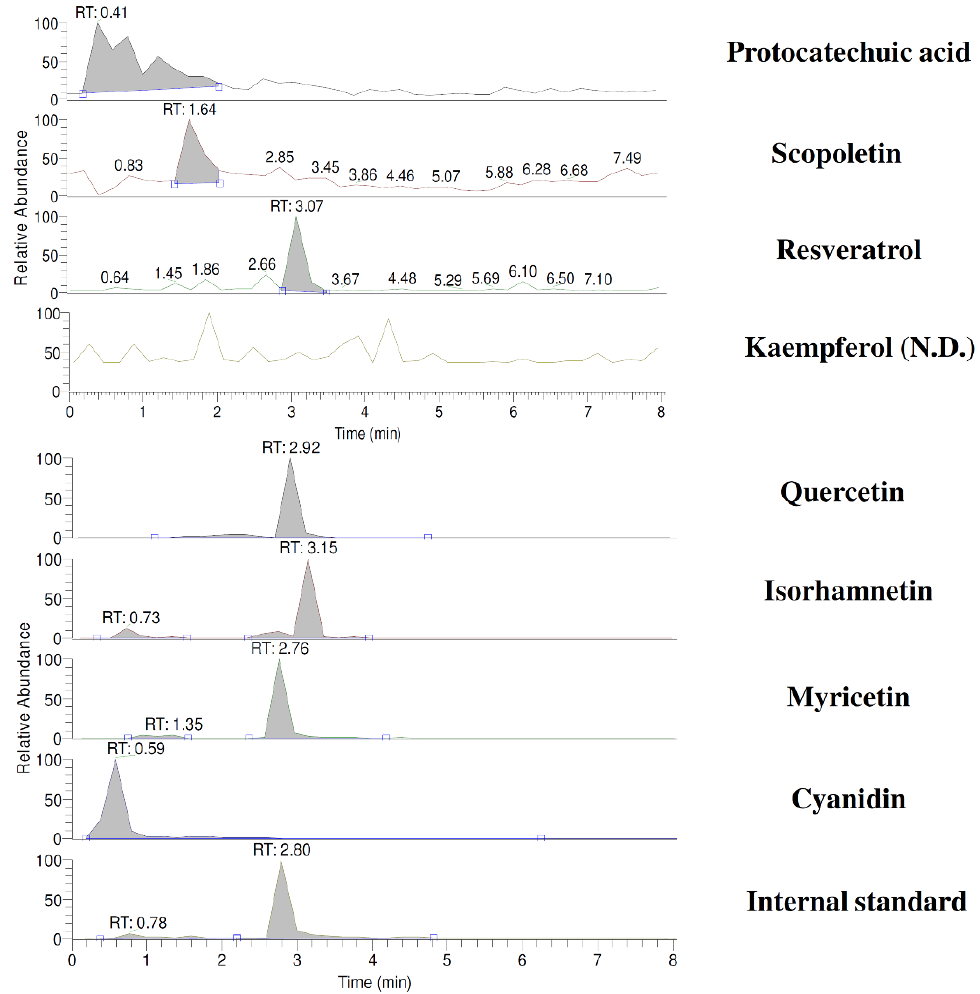
Figure 1. LC/MS/MS chromatograms of cranberry juice. SRM: protocatechuic acid ( m / z 153/108); scopoletin ( m / z 191/176); resveratrol ( m / z 227/185); kaempferol ( m / z 285/151); quercetin ( m / z 301/151); isorhamnetin ( m / z 315/151); myricetin ( m / z 317/151); cyanidin ( m / z 287/213); internal standard, 6,7-DMC ( m / z 207/151). Table 1. Pharmacokinetic parameters of S- and R-warfarin after oral administrations of ( ± ) warfarin (0.2 mg/kg) with and without cranberry juice (CJ, 5.0 g/kg) at 0.5 h before and 10 h after warfarin to 7 rats in each group. Warfarin + Compound Parameters Warfarin Alone